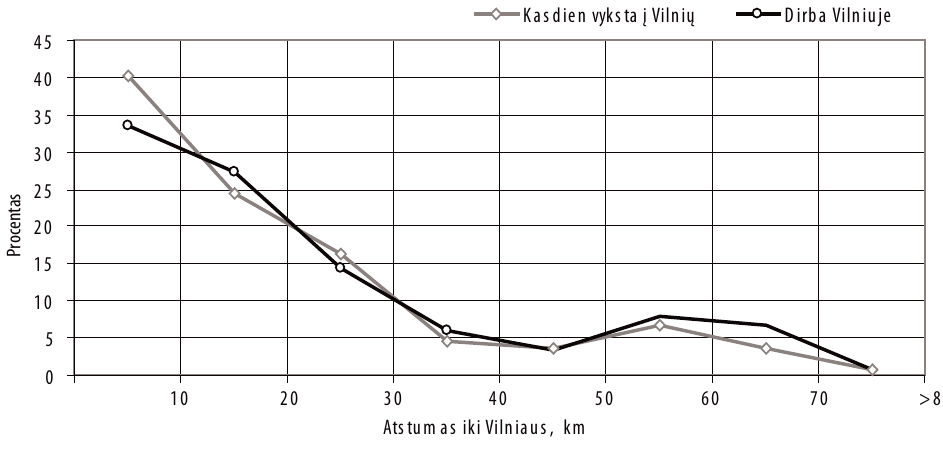
Fig. 3. Connections of inhabitants from non-formal Vilnius region with Vilnius